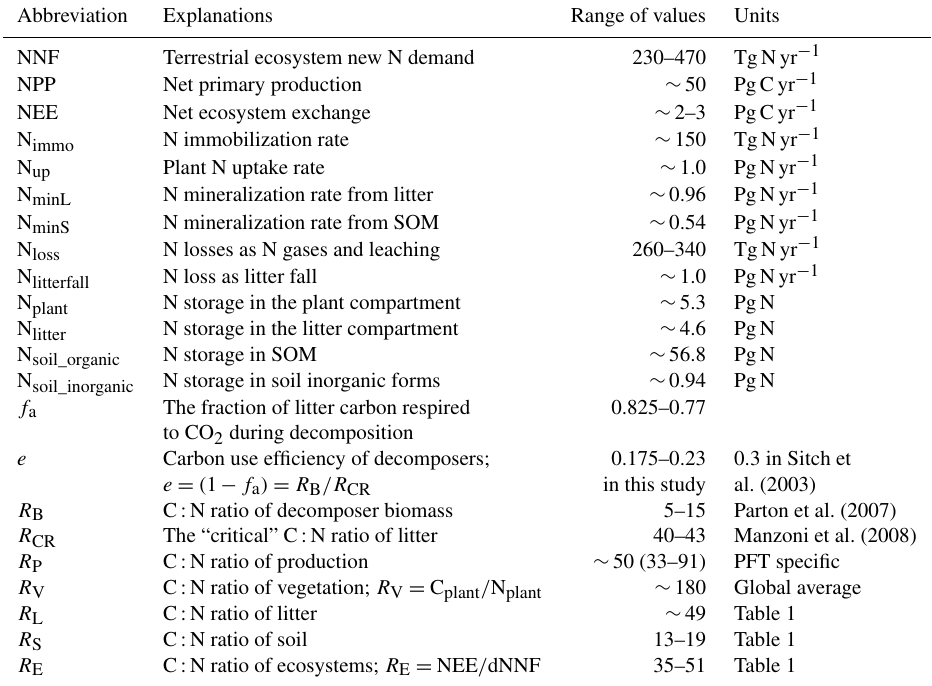
Table A1. Definition of abbreviation, values and